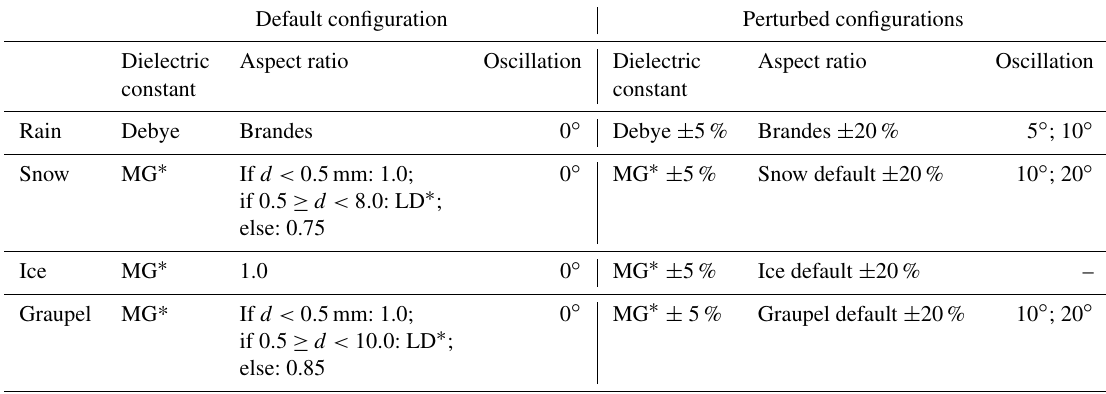
Table 2. Parameters modified to study uncertainties in the H DPOL operator.